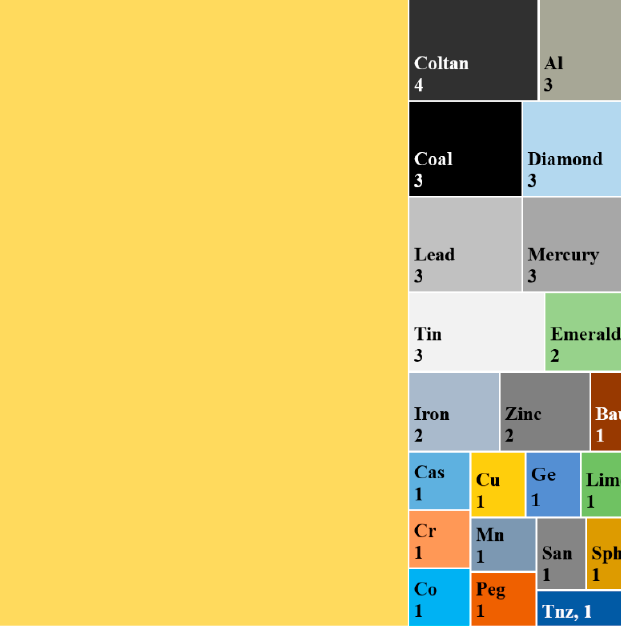
Figure 5. Type of ASM studied as a function of extracted commodities. The numbers indicate the total of reporting studies. Note: Al, aluminium; Bau, bauxite; Cas, cassiterite; Co, cobalt; Cr, chrome; Cu, copper; Ge, gemstones; Lime, limestones; Mn, manganese; Peg, pegmatite; San, sandstones; Sph, sphalerite; and Tnz, tanzanite.